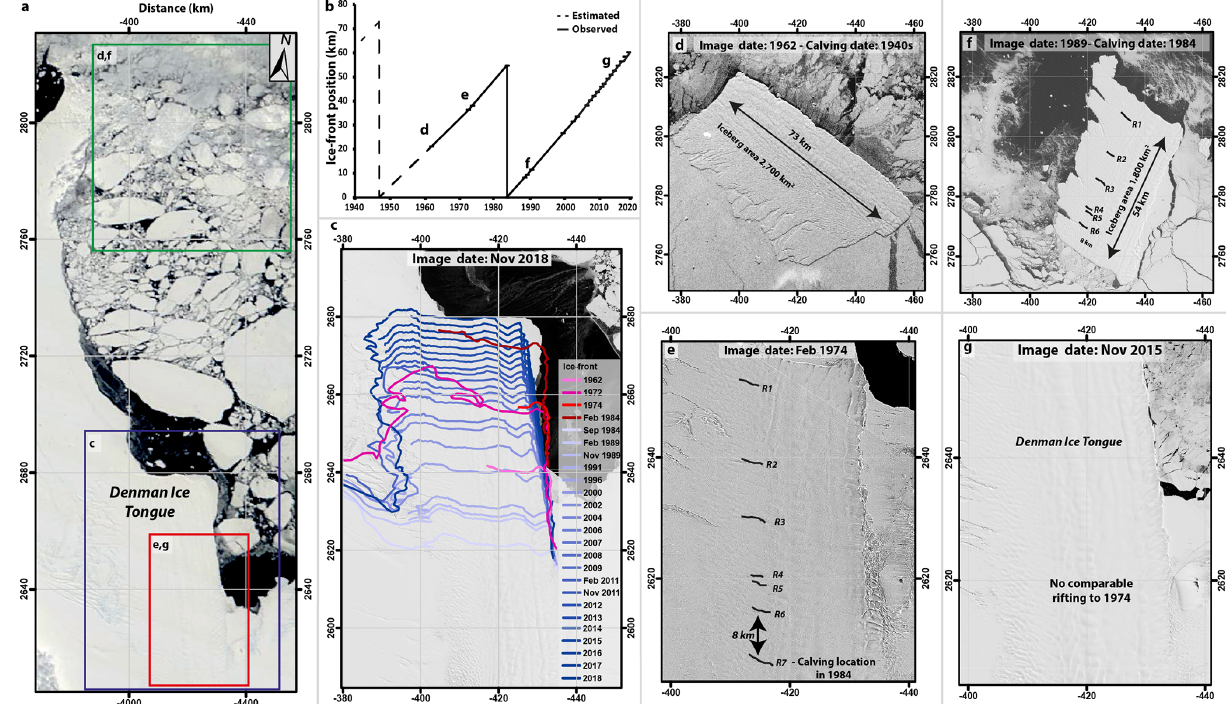
Figure 2. (a) MODIS image from Worldview of the Denman ice tongue in November 2018, with the coloured boxes indicating the locations of panels (c) – (g) . (b) Reconstructed calving cycle of Denman Glacier 1940–2018. (c) Examples of ice front mapping 1962–2018. Note the change in the angle of the ice shelf between its present (light blue–dark blue lines) and previous (pink–red lines) calving cycle. (d) ARGON image of a large tabular iceberg in 1962, which likely calved from Denman at some point in the 1940s. (e) Landsat-1 image of the Denman ice tongue in 1972; note the pattern of rifting, which is digitized in black for increased visibility and labelled R1–R7. (f) Landsat-4 image of a large tabular iceberg which calved from Denman in 1984. Note the rifting pattern and the absence of R7, meaning R7 likely propagated during its calving event in 1984. (g) Landsat-8 image of the Denman ice tongue in 2015. Note the absence of rifting. All Landsat images in this figure have been made available courtesy of the U.S. Geological